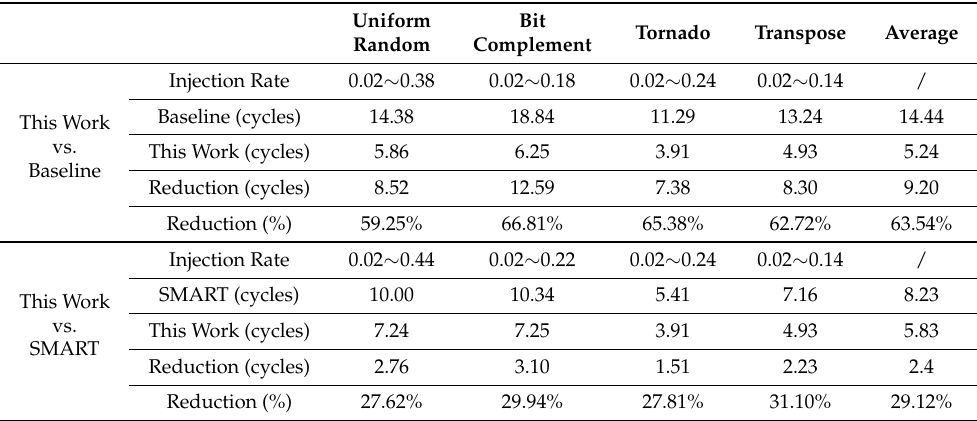
Table 3. Average latency of Proposed NoC, Baseline 1-cycle NoC and SMART.